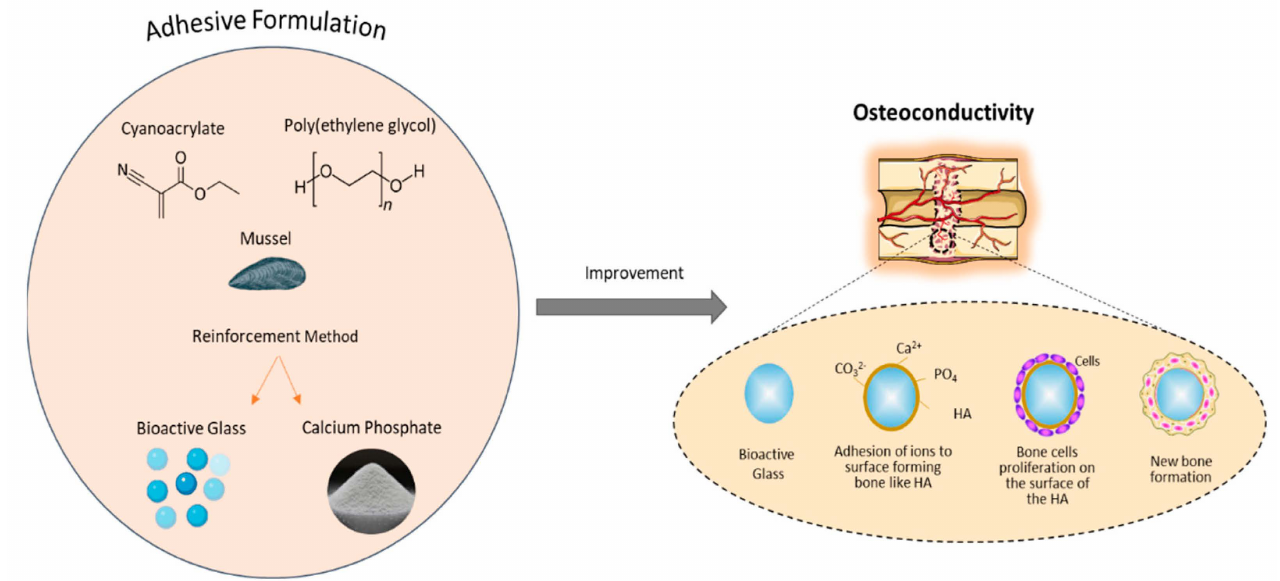
Figure 13. Improved osteoconductivity can be achieved by incorporating bioactive glasses and calcium phosphate-based materials into the adhesive, thereby providing space for bone cell migration, proliferation and